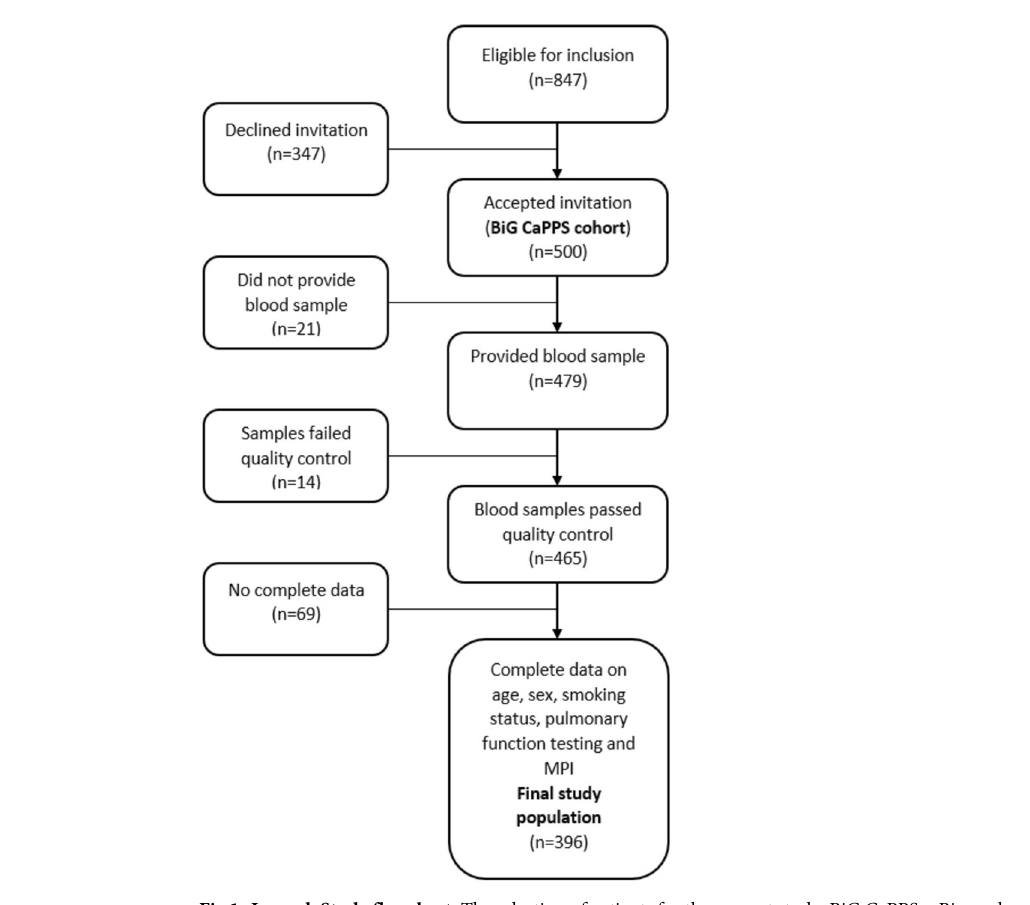
Fig 1. Legend: Study flowchart. The selection of patients for the current study. BiG CaPPS = Biomarkers and Genetics CardioPulmonary Physiology Study.